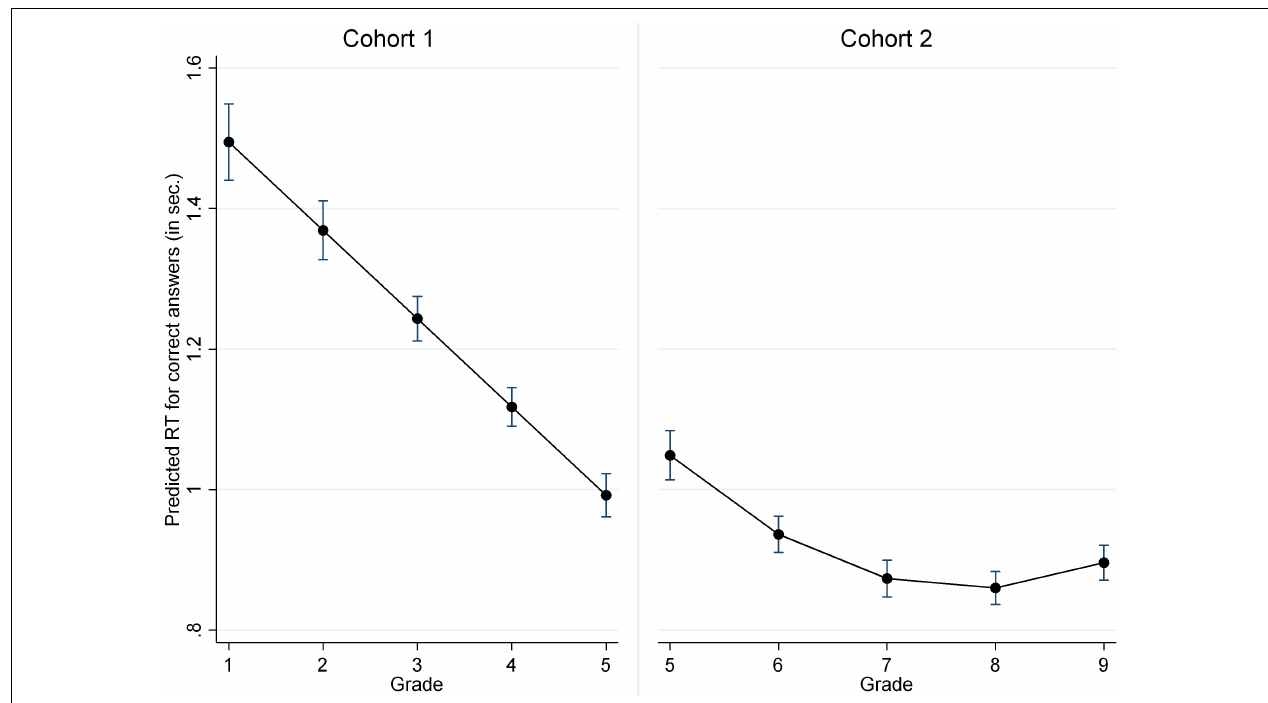
FIGURE 2 | Average predicted trajectories of changes in ANS RT for two cohorts (with 95%